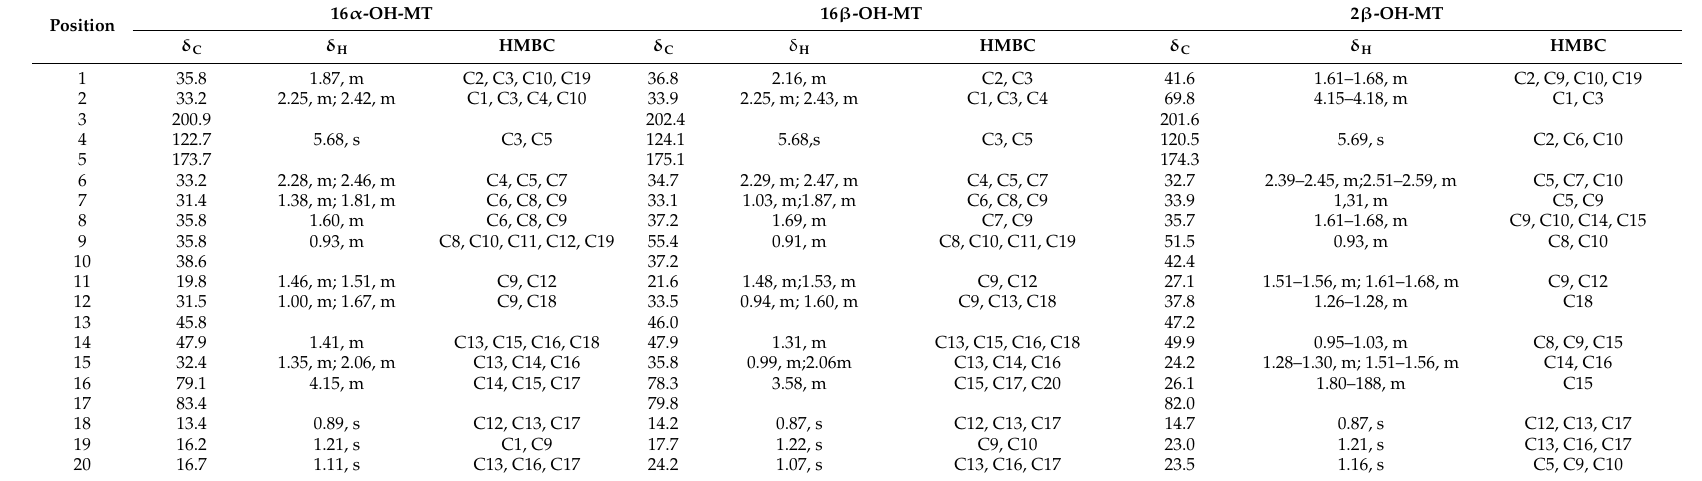
Table 2. NMR data for 16 α -OH-MT, 16 β -OH-MT and 2 β -OH-MT (600 MHz for 1 H-NMR and 150 MHz for 13 C-NMR, D 2 O, δ in ppm) obtained via